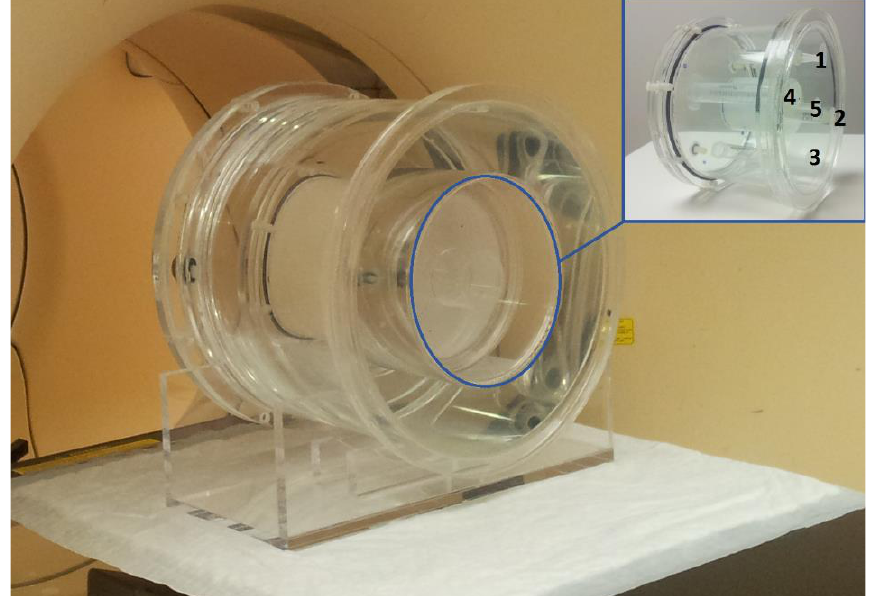
Figure 1. The main photograph shows the entire phantom on its stand with the inner insert containing several PTV cylinders. This inner insert is shown completely empty in the upper-right corner, where the five PTV cylinders are indicated by numbers 1 to 5. The entire phantom shown in the main photograph was captured with the inner insert in place filled with agarose.